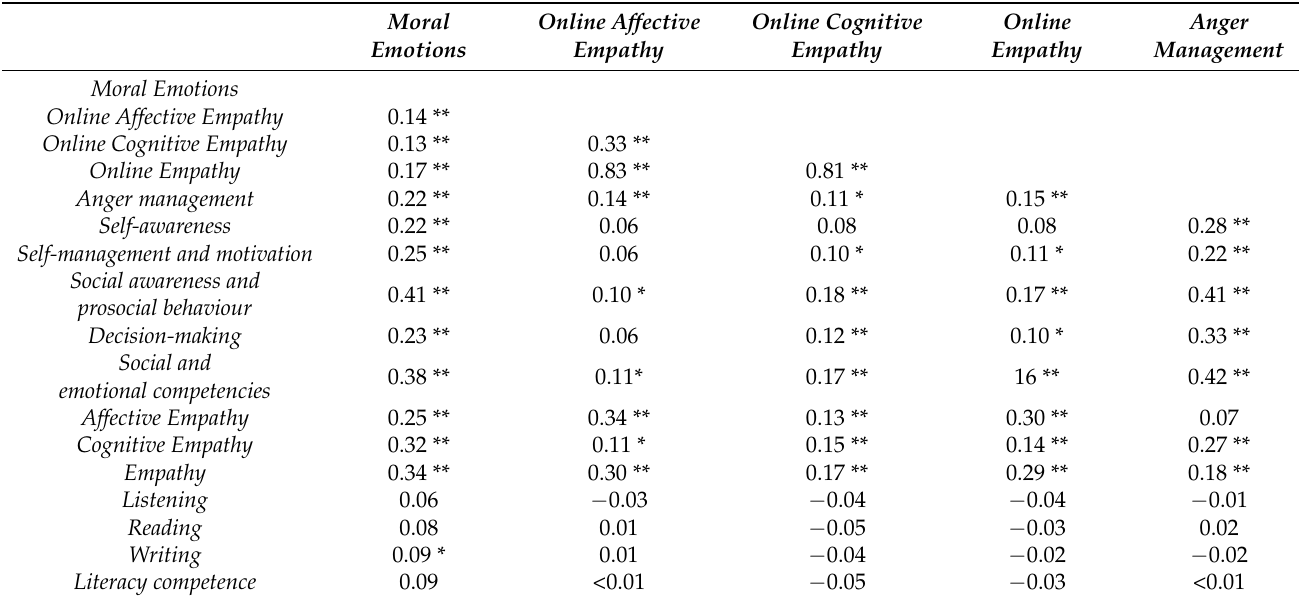
Table 2. Correlations among moral emotions, online empathy, anger management, literacy competence, social and emotional competencies, and